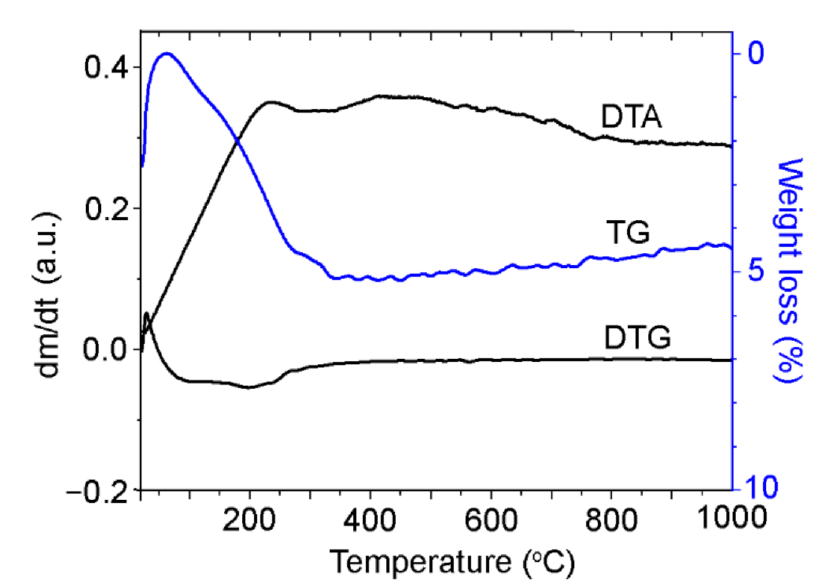
Figure 8. Differential thermal analysis (DTA), differential thermogravimetric analysis (DTG), and thermogravimetric (TG) curves for G/CeO 2 (0.6 mmol/g). Table 6. Pyrolysis yields for TGA pyrolysis of G/CeO 2 (0.6 mmol/g).